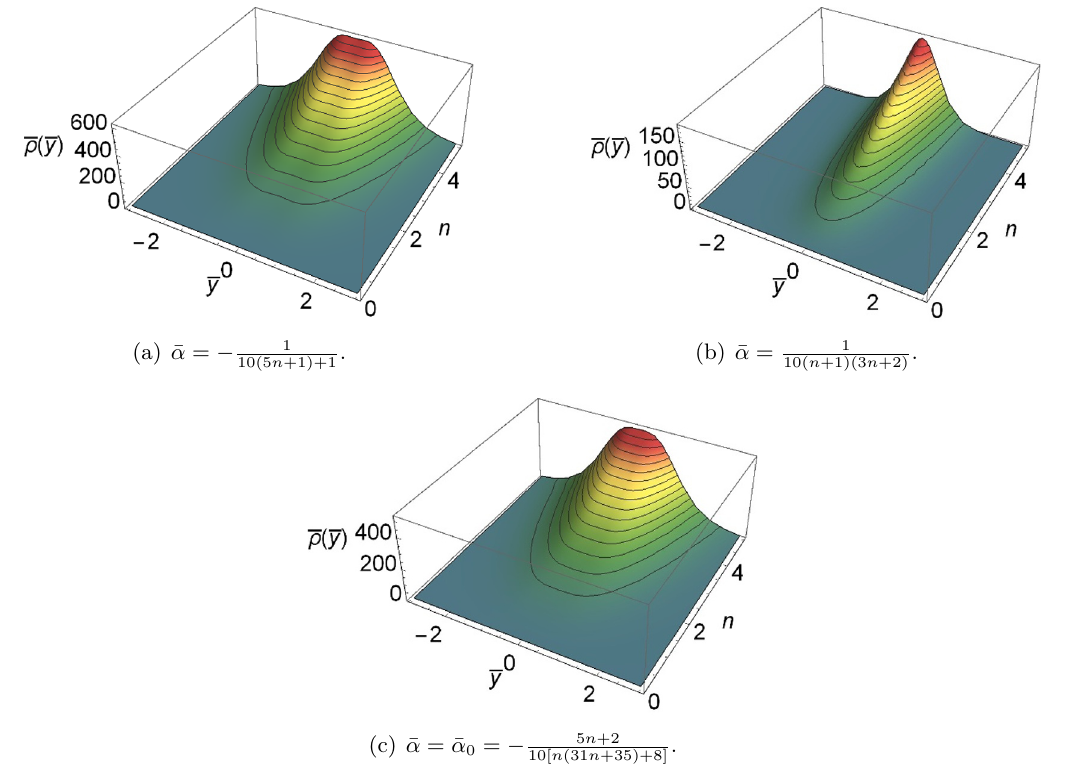
Figure 5 . Plots of the dimensionless energy density ¯ ρ (¯ y ) for the solution (5.10) regarding three values of ¯ α . The energy density in figure 5(a) exhibits split behavior. A non-split energy density is shown in figure 5(b). The energy density at the critical value ¯ α 0 is shown in figure 5(c).